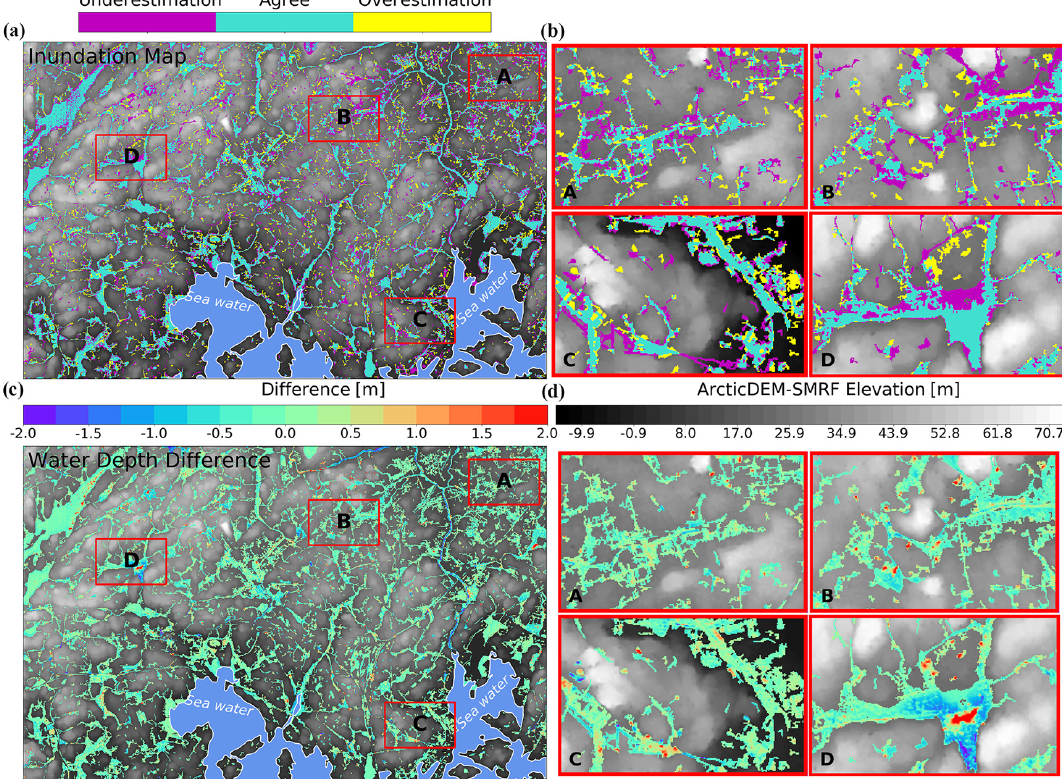
Figure 7. Inundation extent simulated using the optimal ArcticDEM-SMRF parameters (slope threshold = 0.07, window size = 30m) at 10m, where inundation areas that agree with, overpredict, and underpredict the extent of the lidar DTM 10m simulation are shown in (a) . The water depth difference between the ArcticDEM-SMRF and lidar DTM simulations for all wet cells is shown in (b) . Areas with significant disagreement are marked by rectangles denoted A, B, C, and D with the zoomed-in maps displayed in (b) and (d) . The land cover of A and C is building-dominated and of B and D